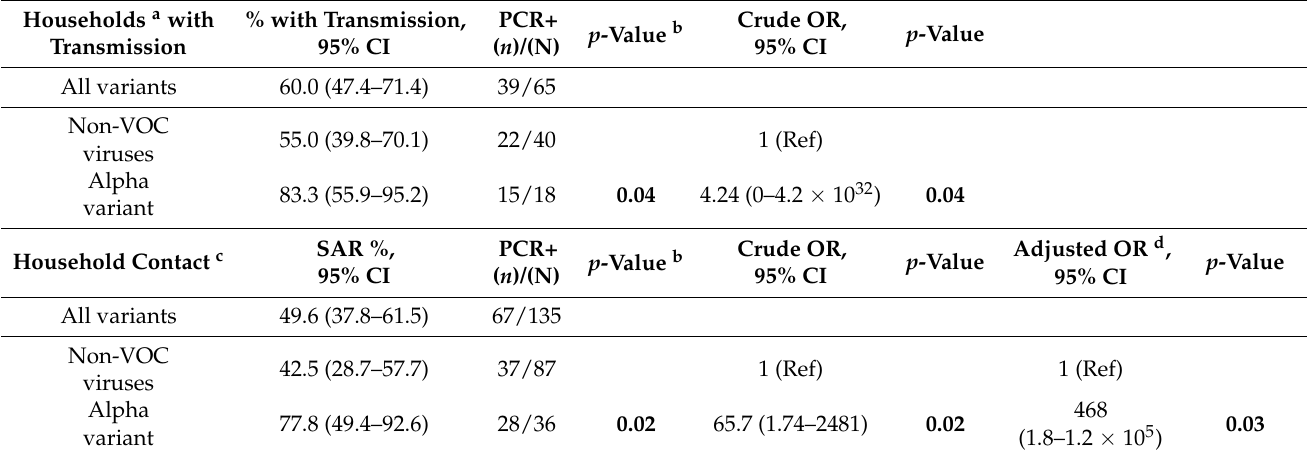
Table 2. Comparison of transmission rates for all households and household contacts, and for Alpha variant versus non-VOC